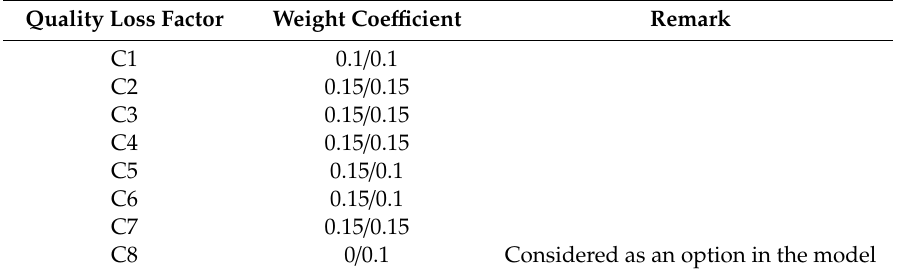
Table 4. The value of the weight coe ffi cient of each quality loss factor in the internal crack generation